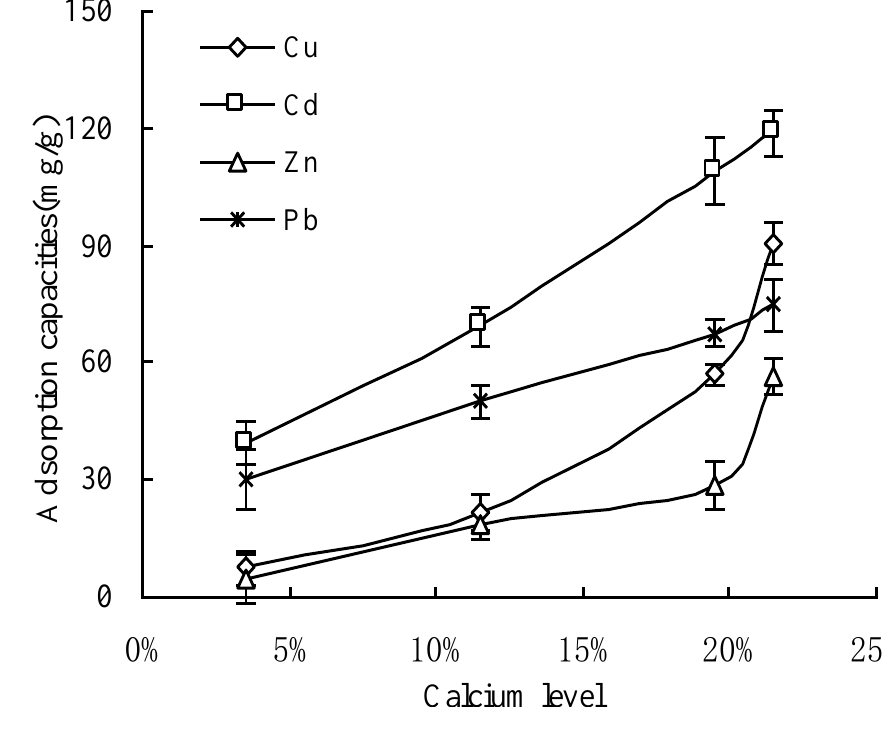
Figure 8 . Adsorption capacities of metal ions on crayfish carapace with different calcium levels (initial metal concentration 100 ppm; agitation